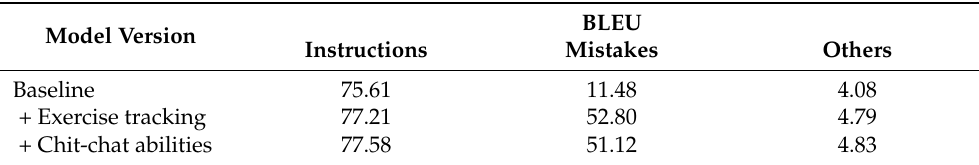
Table 6. Corpus evaluation. Evaluation of our data-driven models (see Section 2.5.6). Scores for each type of system responses are reported separately in columns.